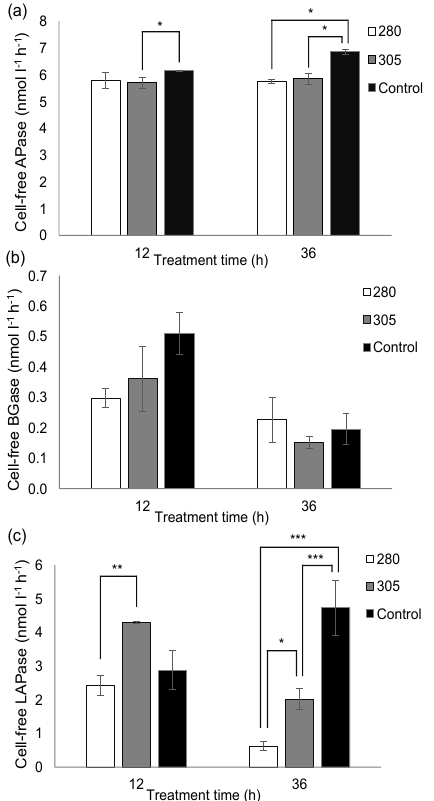
Figure 1. Results from UVR experiments showing the mean ( ± SE) Figure 1. Bar graphs of results fromUVRexperiments showing the mean cell-free extracellular enzyme activity rate for cell-free with standard error bars for alkaline phosphatase(a), β-glucosidase(b)and leucine aminopeptidase(c), cell-free extracellular enzyme activity for alkaline phosphatase (a) , under a high dose of 280nm and above [orange] and a low dose of 305nm and above [yellow] in comparison to dark controls [grey]. Stars above graphs represent individual significant effects between treatments in post hoc Tukey tests beta-glucosidase (b) , and leucine aminopeptidase (c) , under a high (*<0.05, **<0.01, ***<0.001) (N=3). dose (280nm and above) and a low dose (305nm and above) in comparison to dark controls. Asterisks above bars represent indi- vidual significant effects between treatments in post hoc Tukey test ( ∗ <0.05, ∗∗ <0.01, and ∗∗∗ <0.001) ( N = 3).